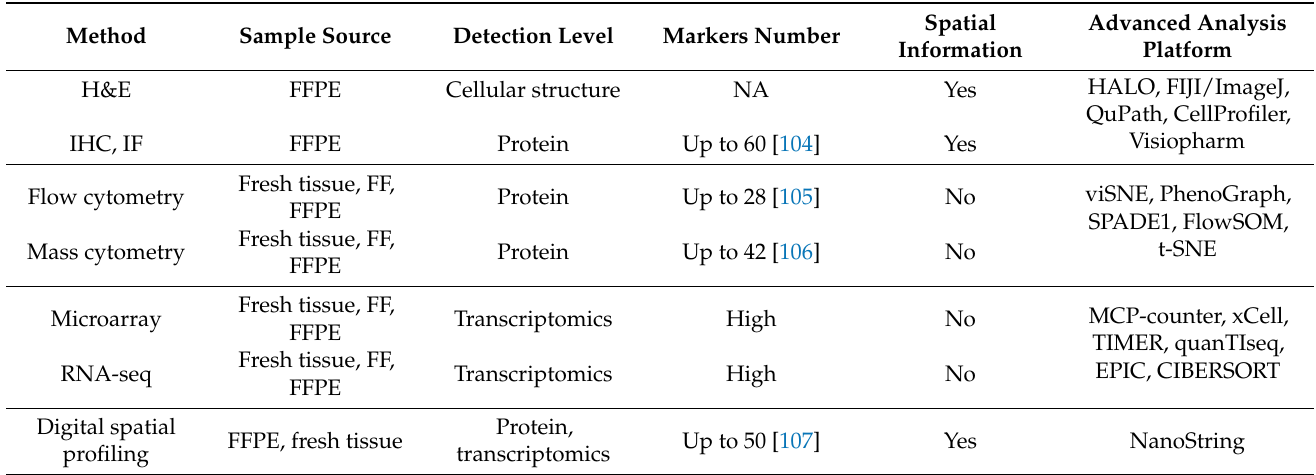
Table 2. Main strategies for measuring tissue-based